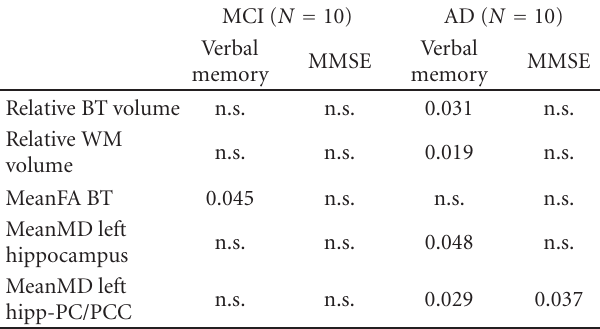
Table 6: Pearson’s Correlation between MR indexes and cognitive